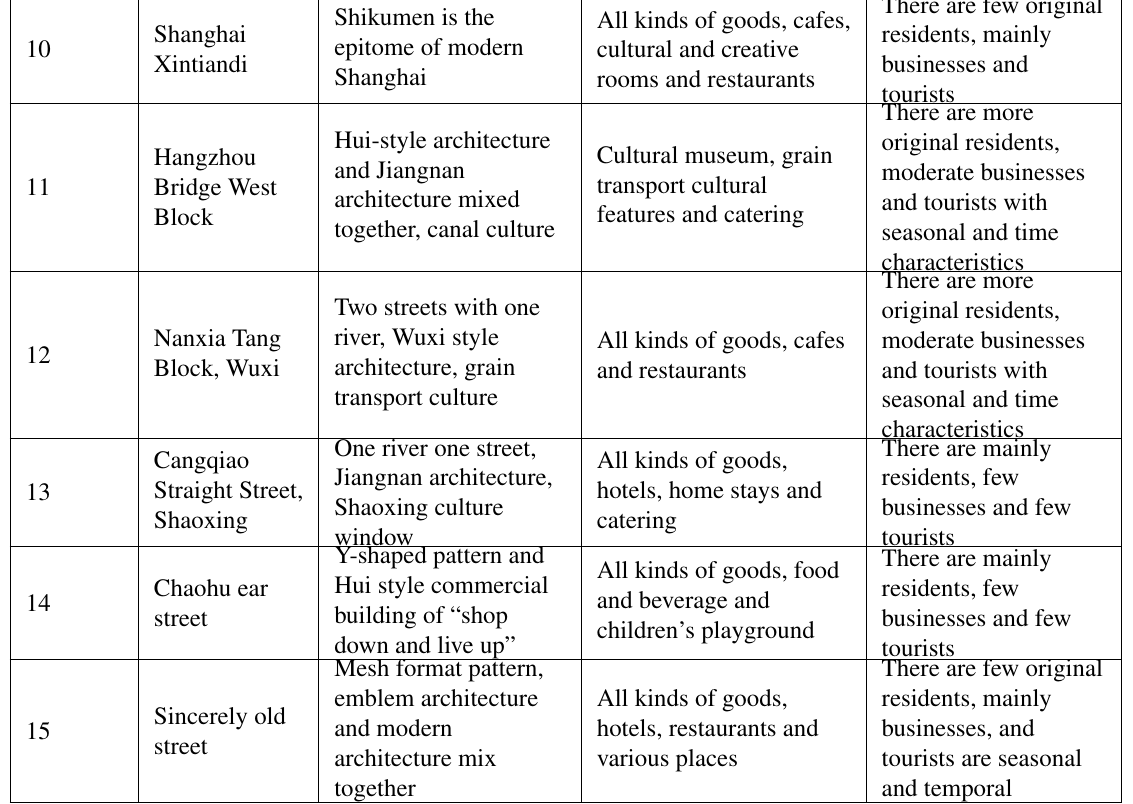
Table 1: The author investigated 15 national and provincial histori- cal and cultural blocks in Jiangnan